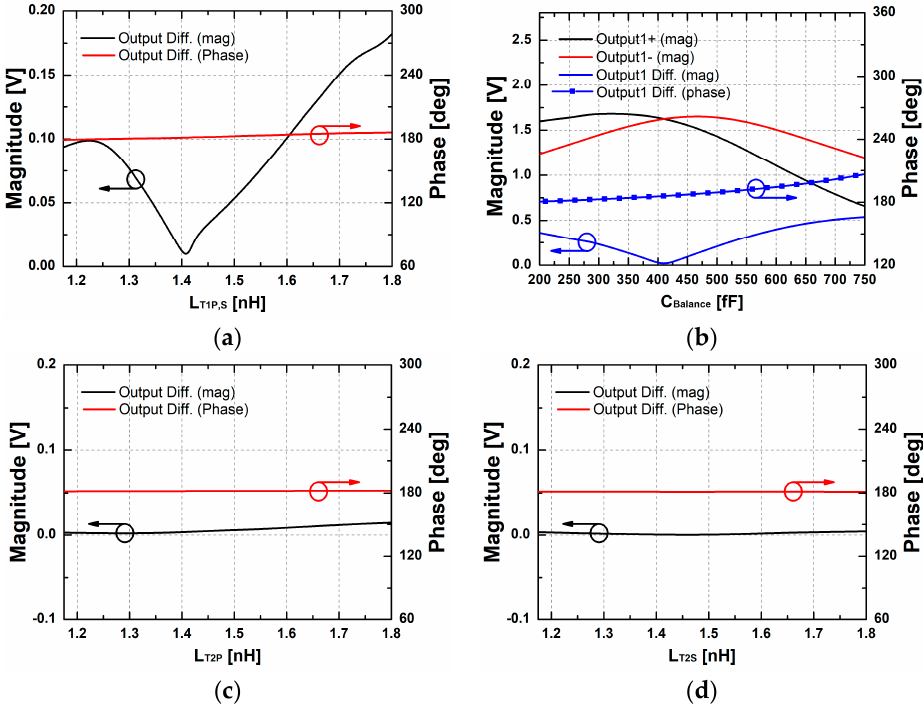
Figure 2. The magnitude and phase of the symmetric inductor as a function of the optimization of ( a ) L T1P,S , ( b ) C Balance , ( c ) L T2P , and ( d ) L T2S .